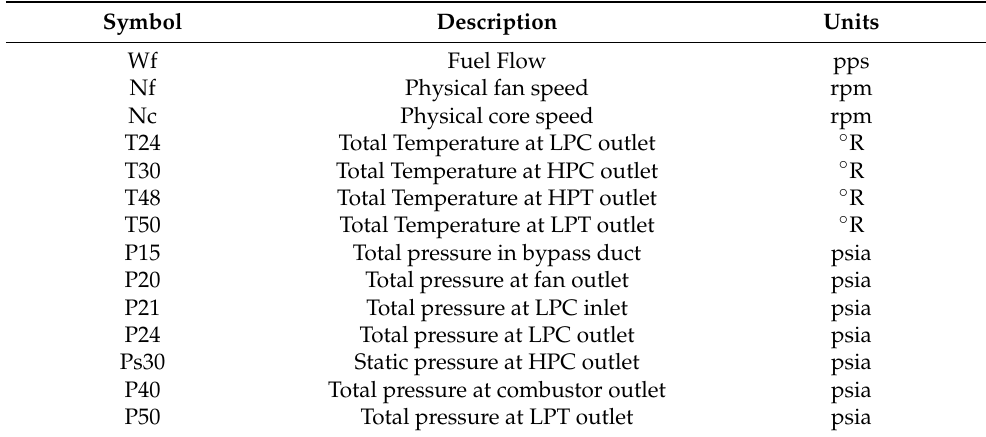
Table 2. N-CMAPSS engine performance